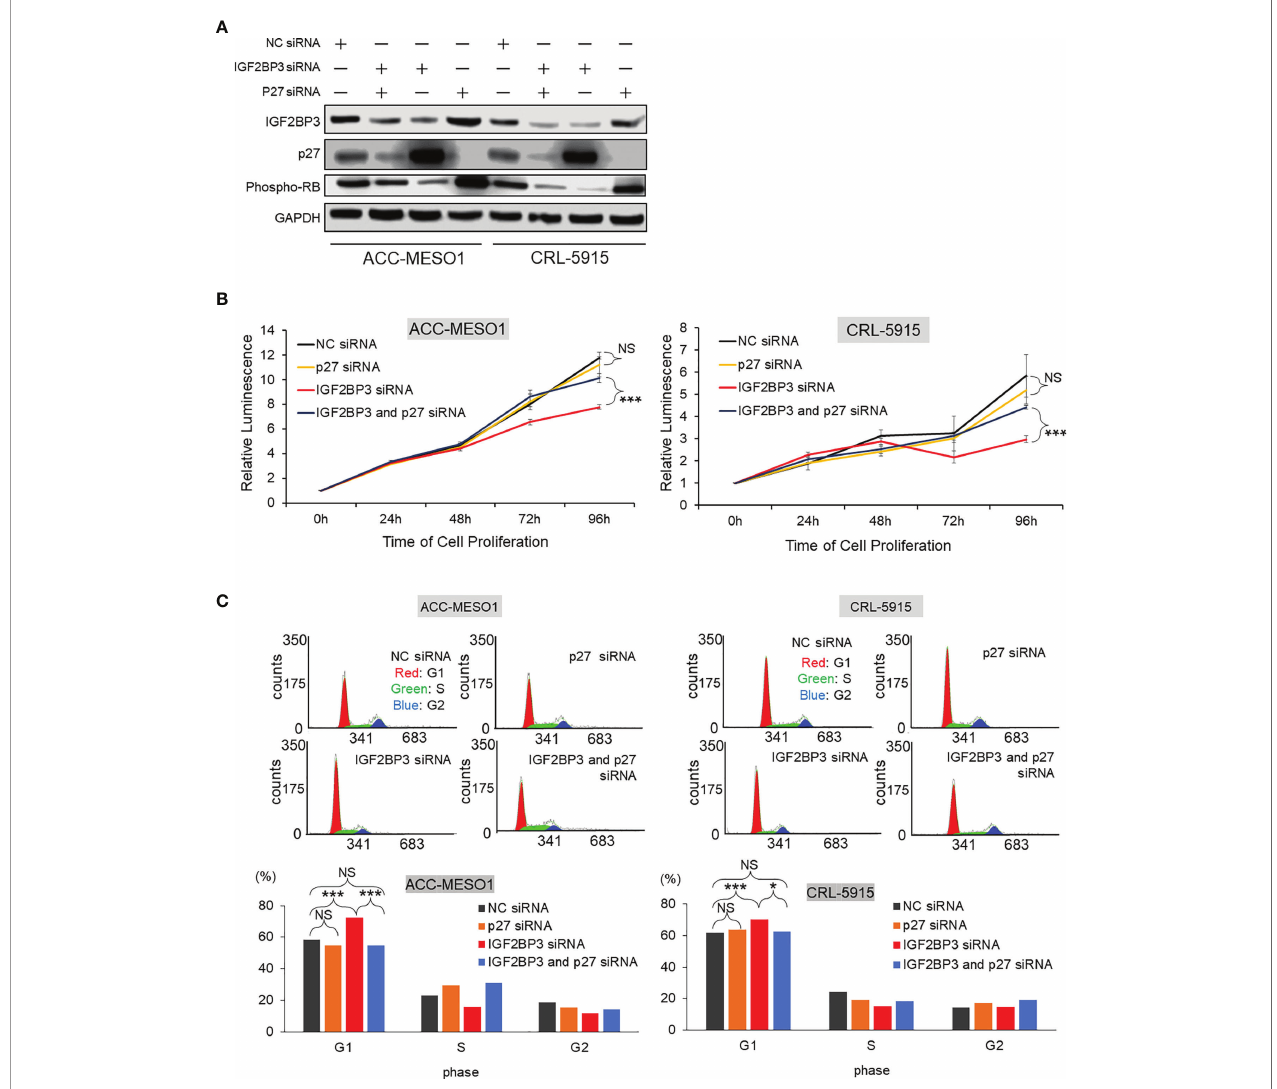
FIGURE 5 | Effect of IGF2BP3 and p27 on cell proliferation and G1 cell cycle phase arrest. (A) Western blot of IGF2BP3, p27, and phospho-RB proteins. IGF2BP3 or p27 siRNA- transfected cells show the suppression of speci fi c protein expression in ACC-MESO1 and CRL-5915 cells. Cell lines transfected simultaneously with both IGF2BP3 and p27 siRNAs re-diminish p27 protein expression and recover phospho-RB protein expression. (B) Cell proliferation assay. In ACC-MESO1 and CRL-5915, transfection with IGF2BP3 siRNA and p27 siRNA together show a signi fi cant increase in cell proliferation at 72 h and 96 h from transfection of IGF2BP3 siRNA alone. Note the cells transfected with p27 siRNA alone show no signi fi cant change from those transfected with NC siRNA. (C) Cell cycle assay. ACC-MESO1 and CRL-5915 cells transfected with IGF2BP3 siRNA and p27 siRNA together, show signi fi cant reduction in the percentage of cells in G1 phase of the cell cycle. Note the cells transfected with p27 siRNA alone show no signi fi cant difference in the percentage of cells in G1 phase compared with those cells transfected with NC siRNA. NC, Negative control; NS, no signi fi cance; * p < 0.05; *** p <